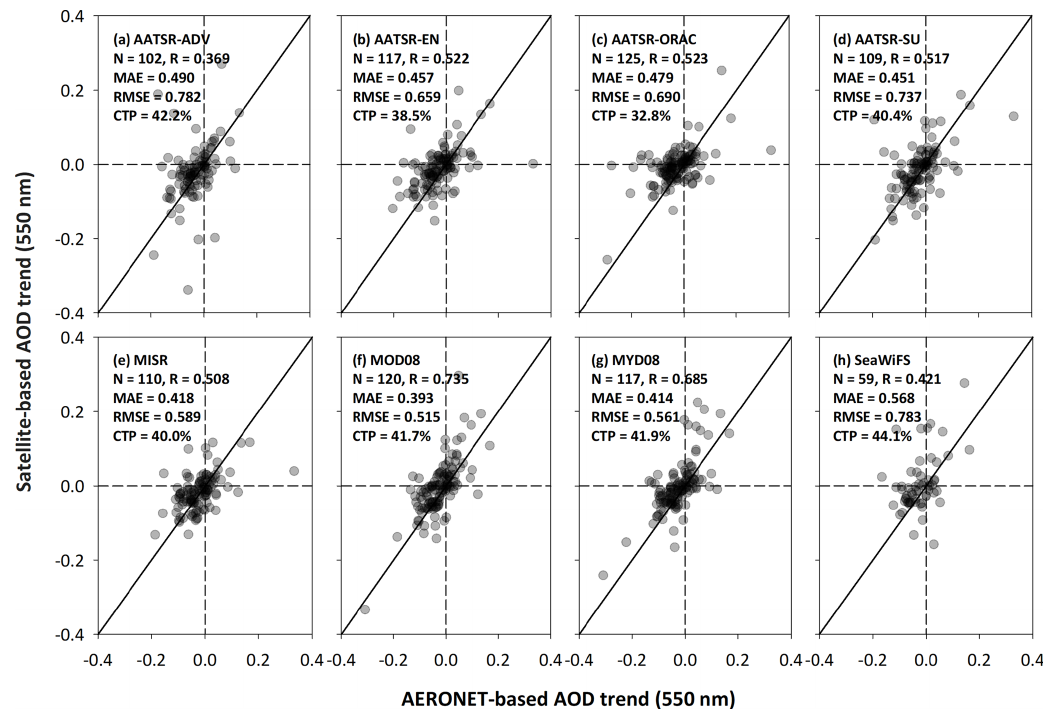
Figure 16. Comparisons between the linear trends based on the de-seasonalized monthly AOD S anomalies from 2003 to 2010. Units are AOD per decade. The solid black line represents the 1 : 1